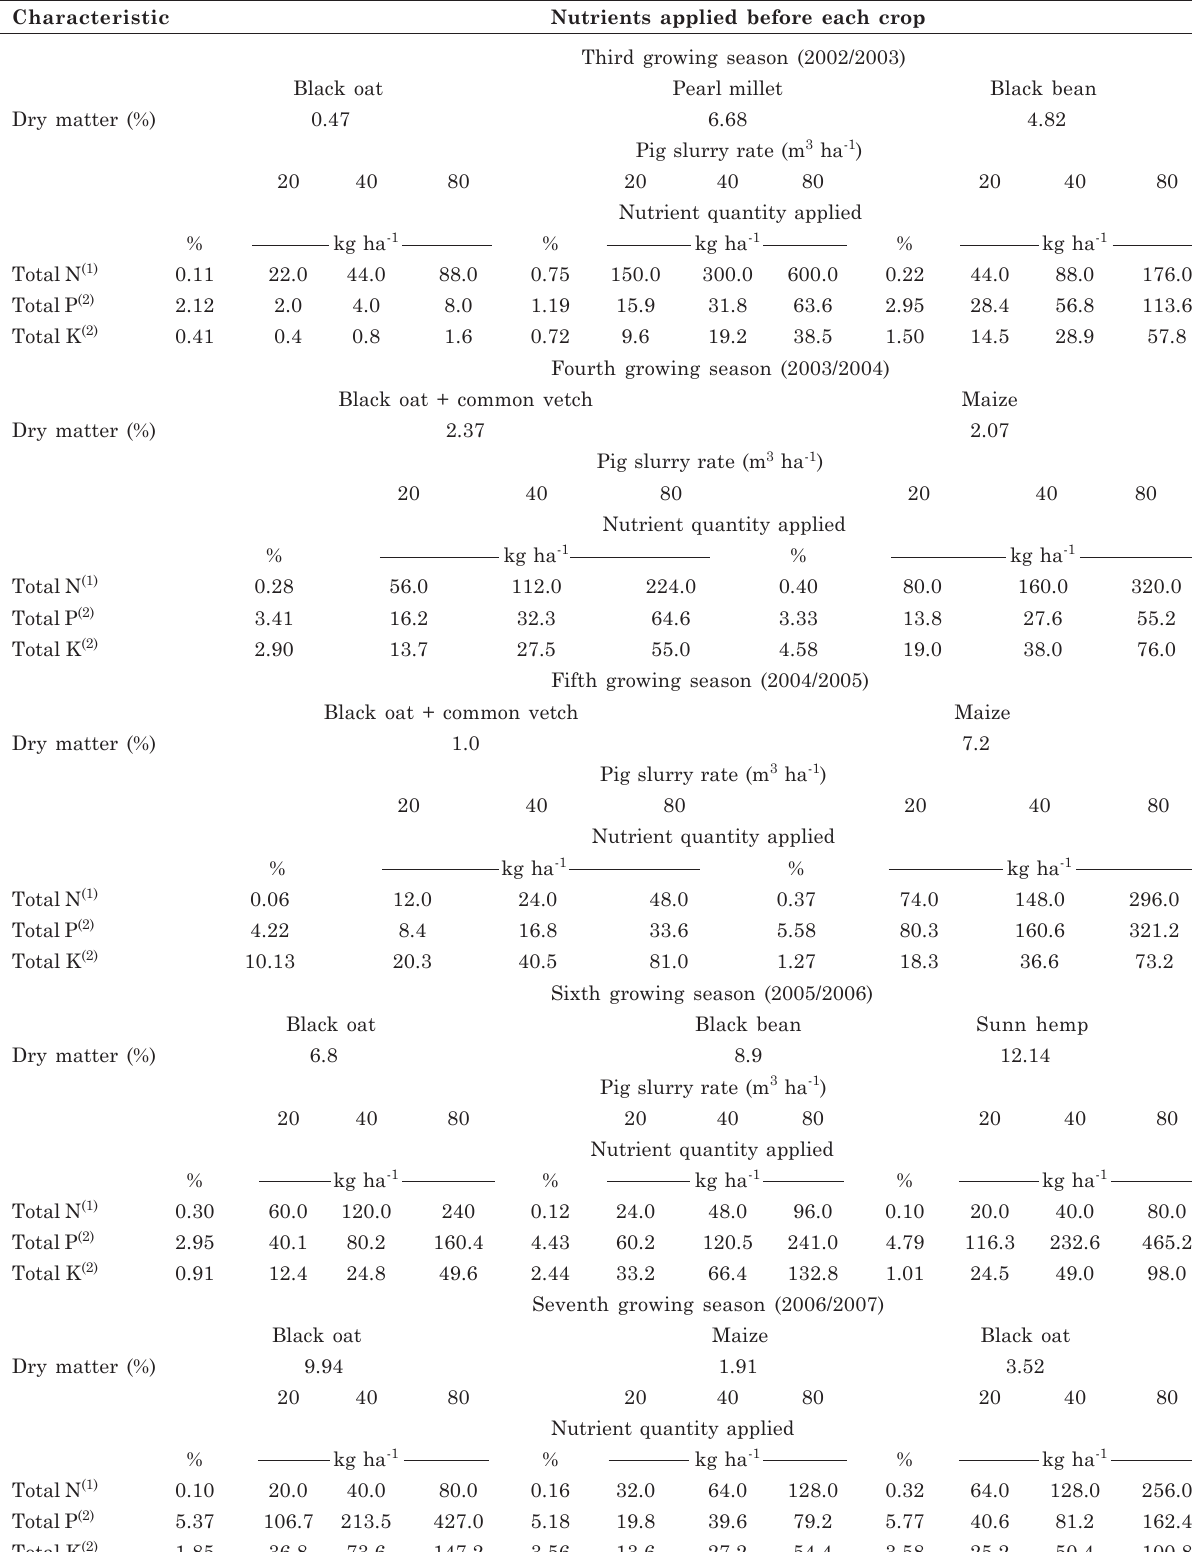
Table 2. Characteristics of pig slurry (PS) and the quantity of nutrients applied before putting in each crop over the 93 months of the